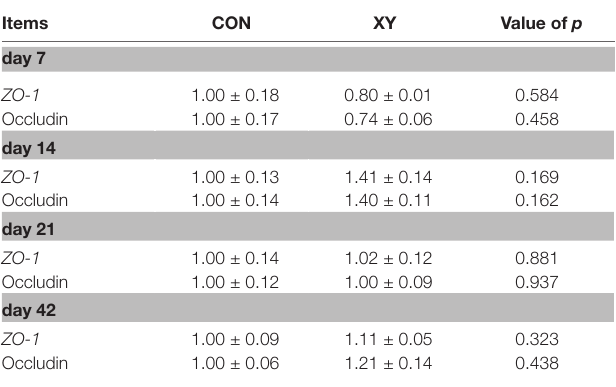
TABLE 6 | Effects of AT-xynA on ileal immune function of broilers. 1 Items CON XY Value of p